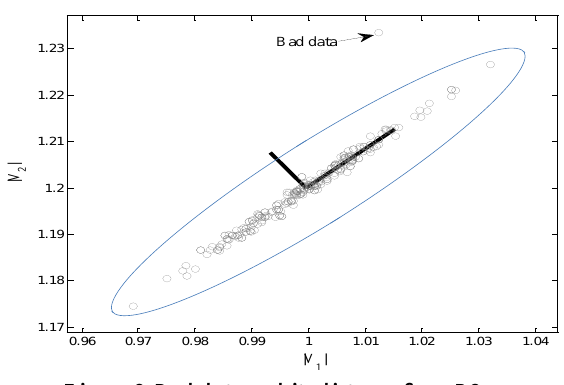
Figure 6. Bad data and its distance from